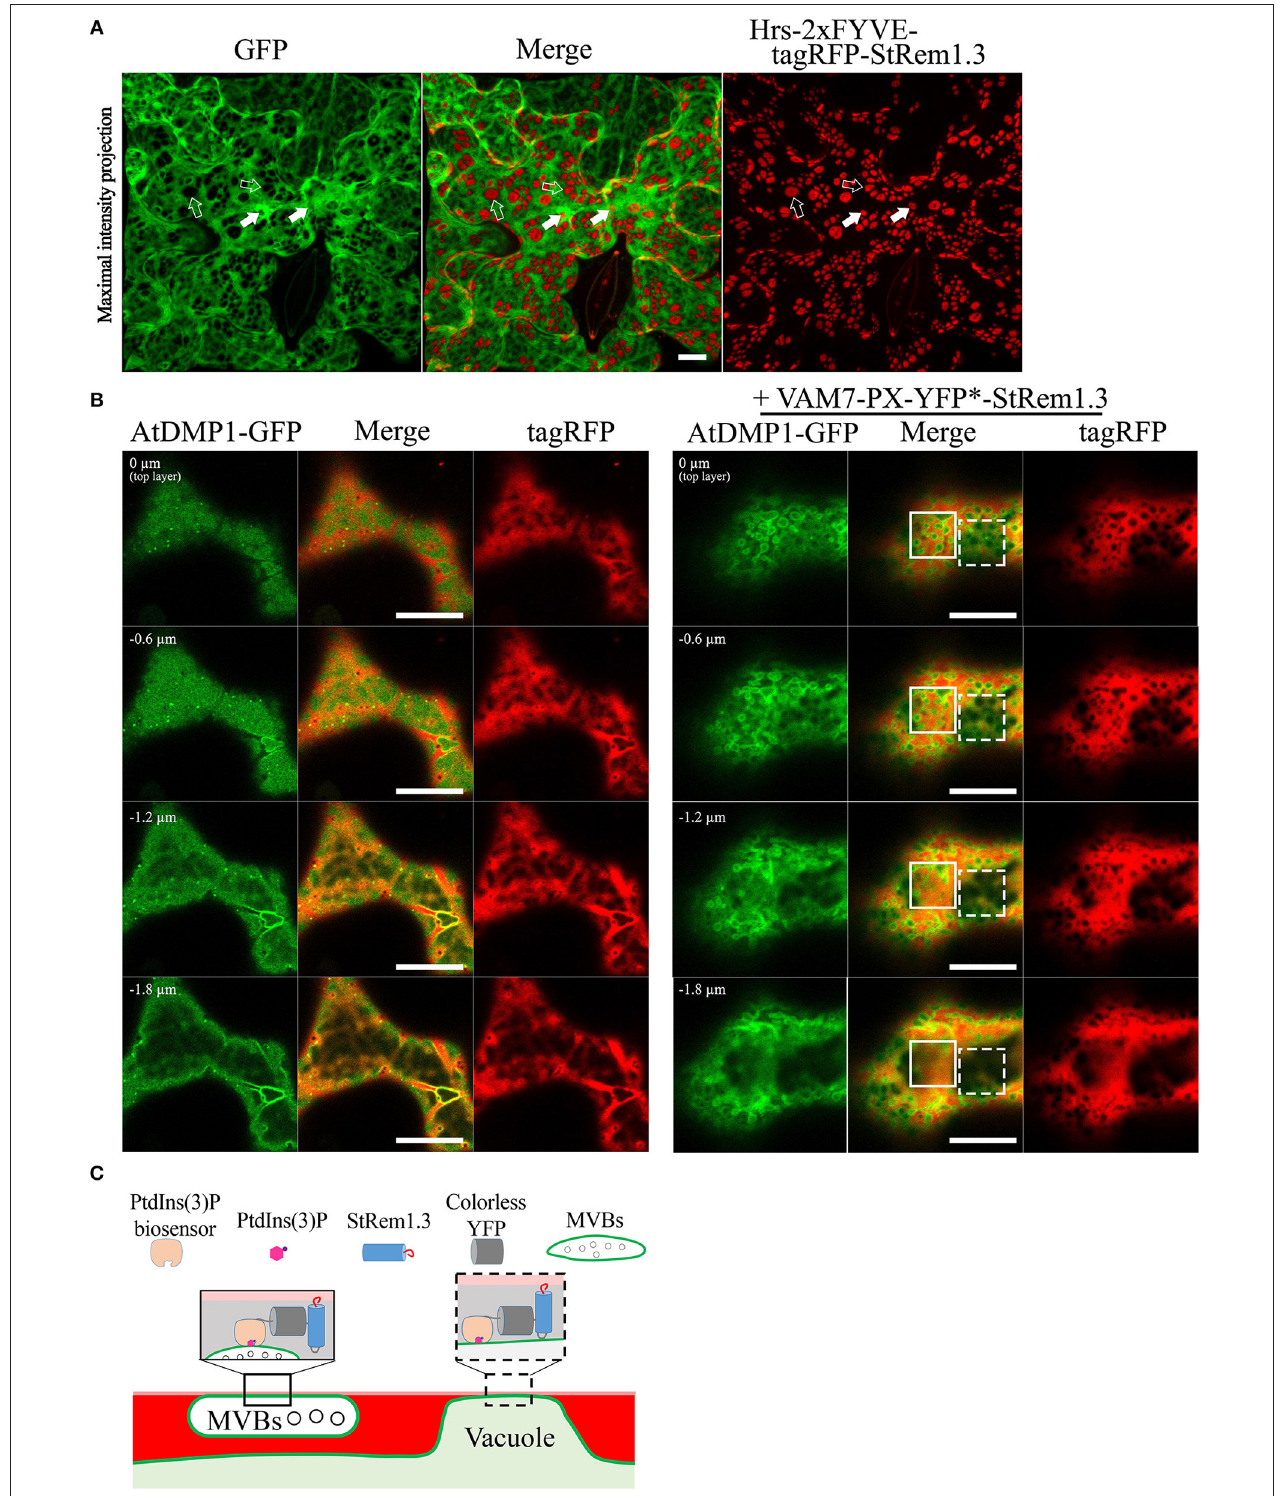
FIGURE 4 | Distribution of cytoplasm-targeted free fluorescent proteins in the presence of membrane patches. (A) Soluble GFP showing exclusion by membrane patches produced by Hrs-2xFYVE-tagRFP-StRem1.3 (negatively stained holes in GFP panel). Examples of tonoplast-associated patches from which GFP has been excluded are highlighted with open arrows, and punctae are highlighted by dotted arrows. Examples of MVB-associated patches from which GFP has not been